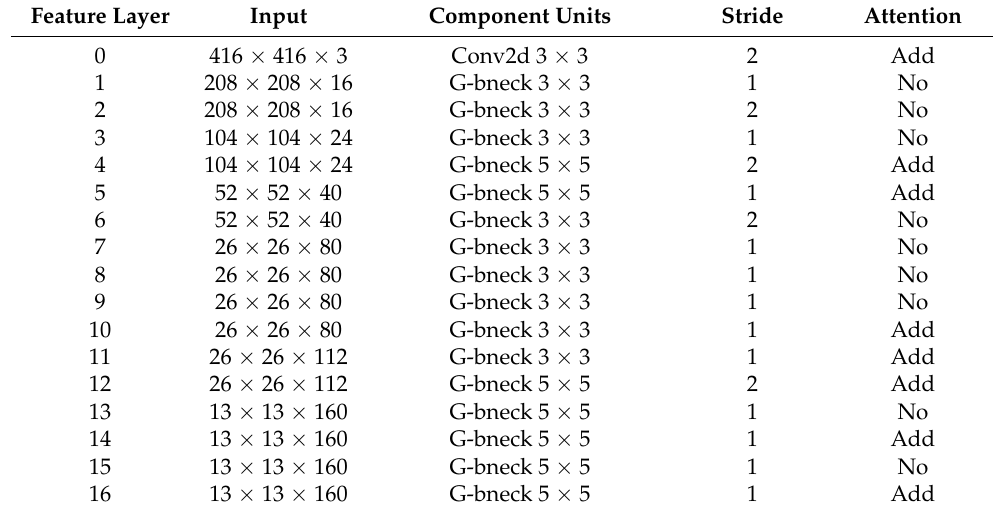
Table 1. Hardware and software